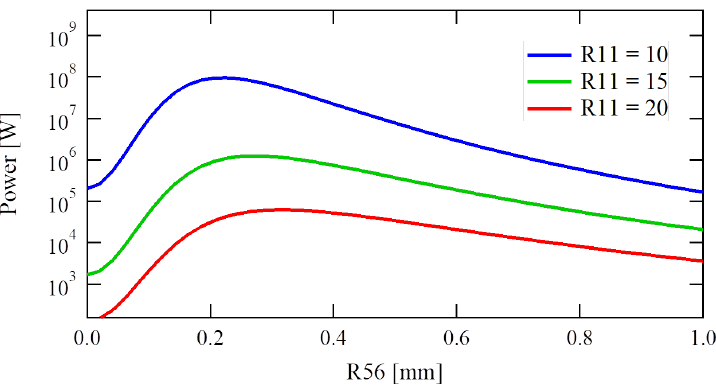
Figure 3. Free Electron Laser (FEL) power emitted after 2 m long undulator section as the magnification R 11 and chicane strength R 56 vary.